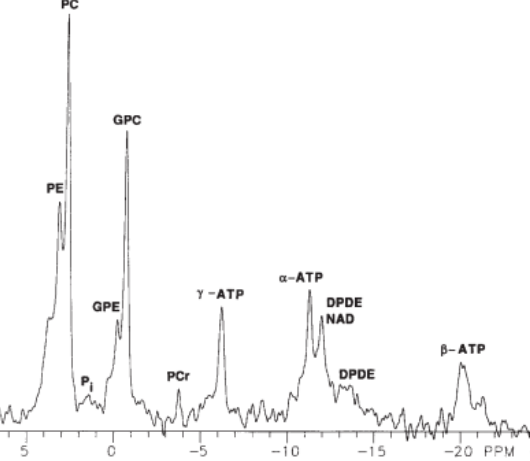
Figure 6. Representative 31 P NMR spectrum at 162 MHz of wild- type MCF-7 human breast cancer cells (~10 8 /ml) perfused with IMEM media (Pi-free) in agarose gel thread (0.5 mm); 200 scans were accumulated with a recycle time of 40 sec and a 90° pulse. The peak assignments are denoted: PE, PC, Pi, inorganic phosphate; GPE, GPC, PCr, phosphocreatine; ATP, adenosine triphosphate, DPDE, diphosphodiesters; NAD, nicotine adenine dinucleotide.